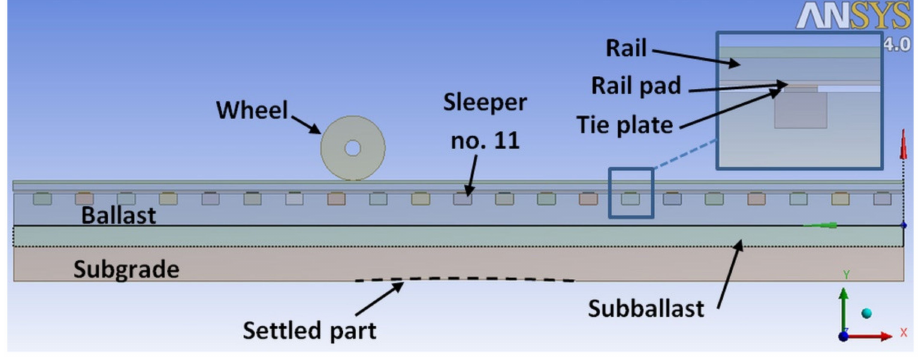
Figure 3. Track geometry in the FE model.